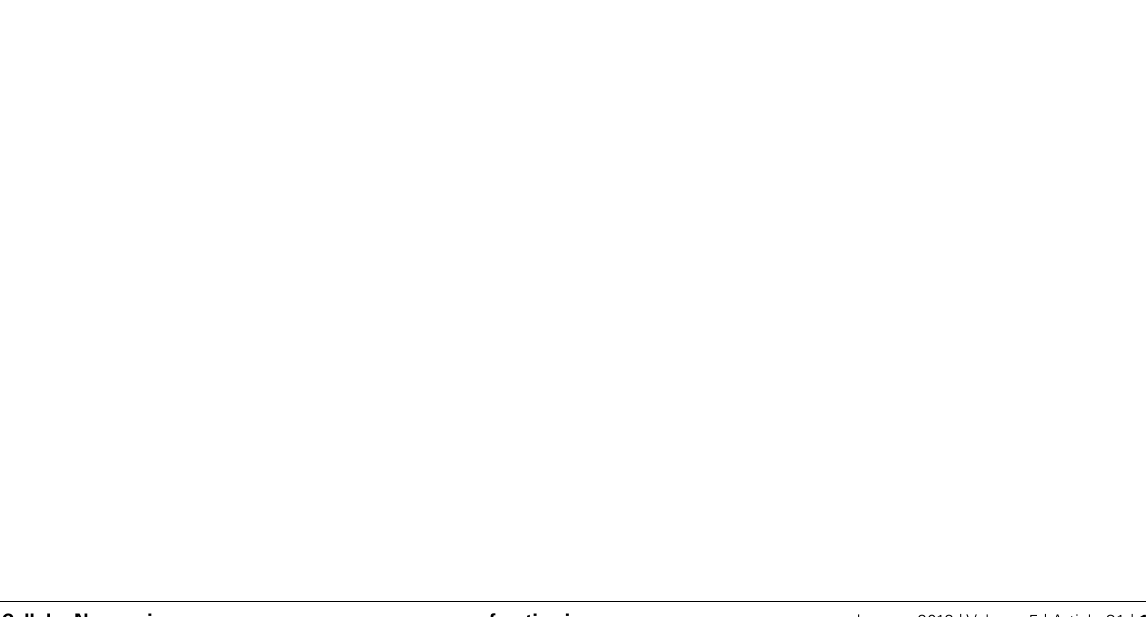
FIGUREA1 | sEPSPs. (A) Visual description of the algorithm used to find spontaneous excitatory postsynaptic potentials (sEPSPs) in voltage traces. Raw data were smoothed lightly (dark and light blue traces, respectively) and convolved (green trace) with a template. Peaks in the convolution correspond to where the data best match the template; thus, to find candidate sEPSPs, the convolution was subjected to a threshold (black line). For each event, if the amplitude exceeded a size threshold, which was taken as a fraction of the SD of the smoothed data, it was identified as an sEPSP (red asterisk; the template, scaled to each sEPSPs individual amplitude, is superimposed on